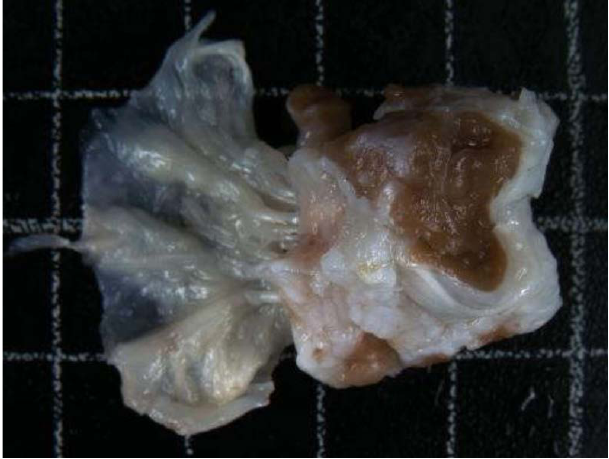
Fig. 4 - A thickened tricuspid valve leaflet of heterogeneous thickness, with thickened and retracted chordae tendineae.